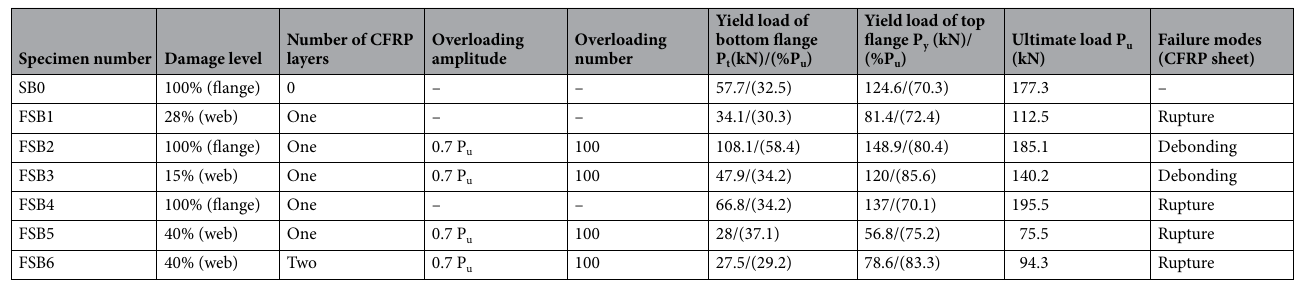
Table 1. Test matrix and